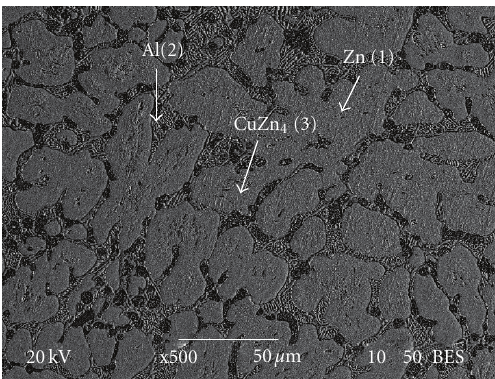
Figure 1: Microstructure of Zn-10% Al-1.5% Cu after the anneal-